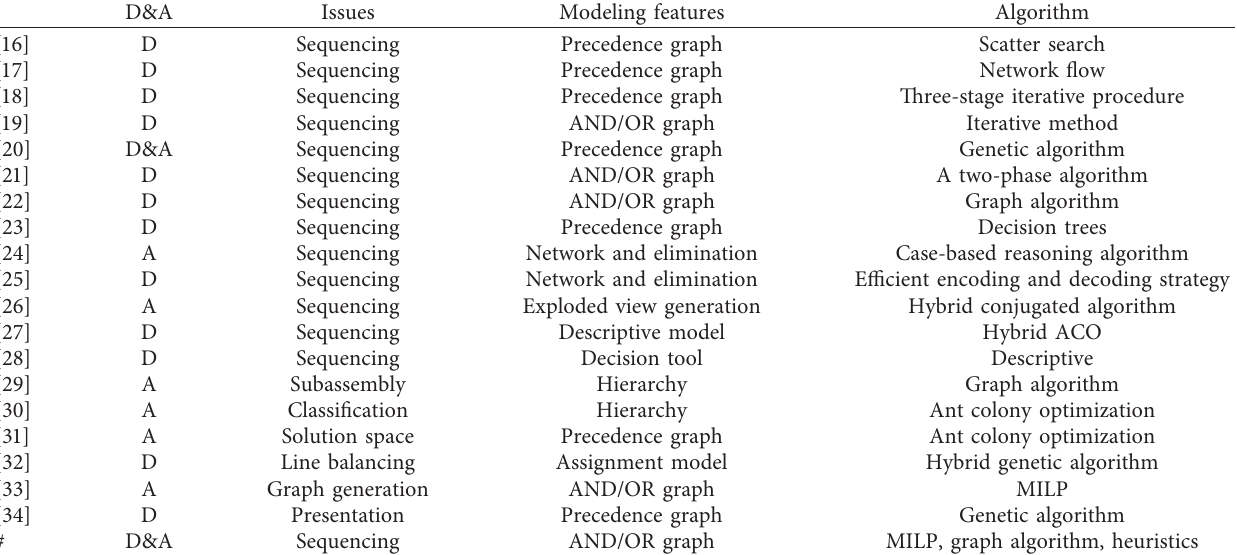
Table 1: Pioneering studies on D&A operations